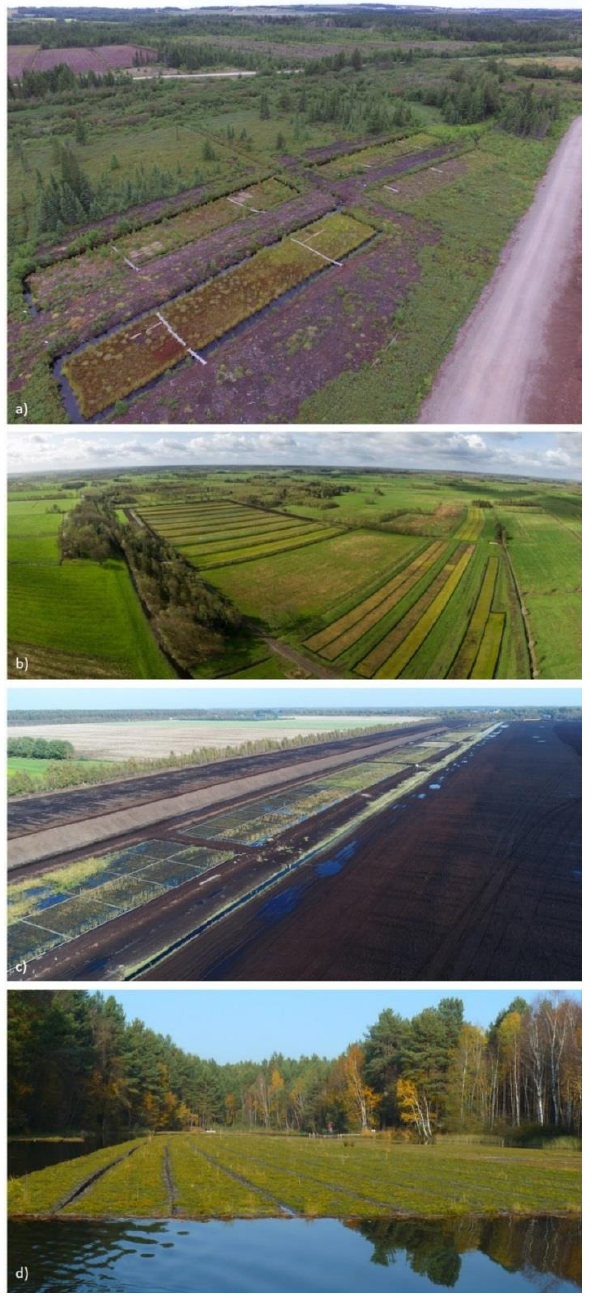
Figure 2. Overviews of Sphagnum farming sites, a) on cut-over bog in Canada; b) on former bog grassland in Germany (Rastede); c) on cut-over bog in Germany (Drenth); and d) on floating mats on a lake in Germany. Photos: a) Peatland Ecology Research Group, b) ASEA aerial, c) Jan Köbbing and d) Matthias